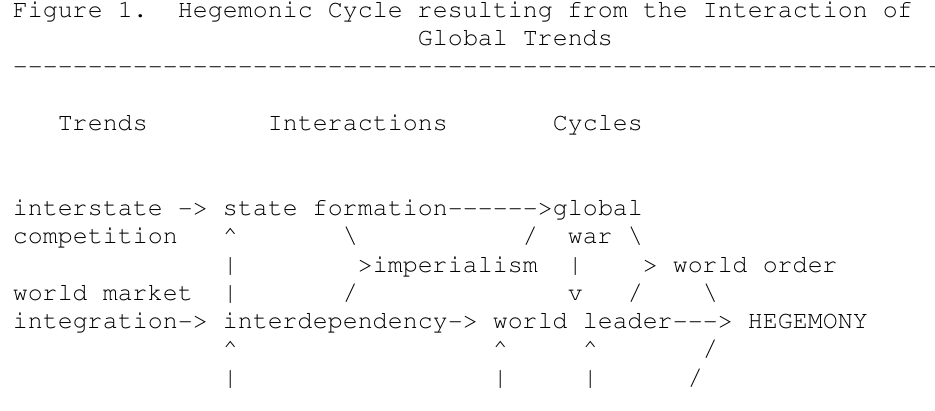
Figure 1. Hegemonic Cycle resulting from the Interaction of Global Trends ---------------------------------------------------------------- Trends Interactions